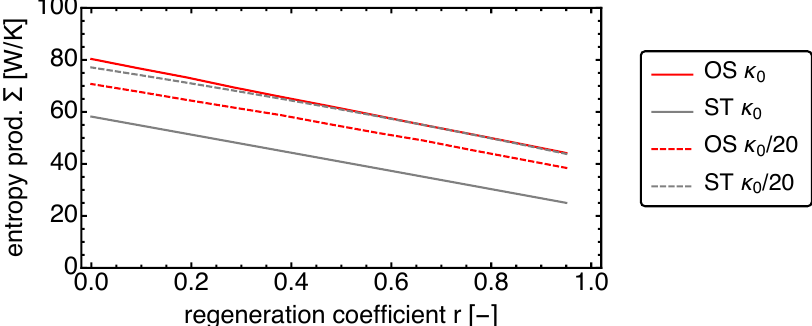
Figure 9. The cycle averaged entropy production rate is shown as a function of the regeneration coefficient r for the reference case in comparison with the low conductance case . For the reference case the OS motion leads to a stronger increase in the entropy production than for the low conductance case